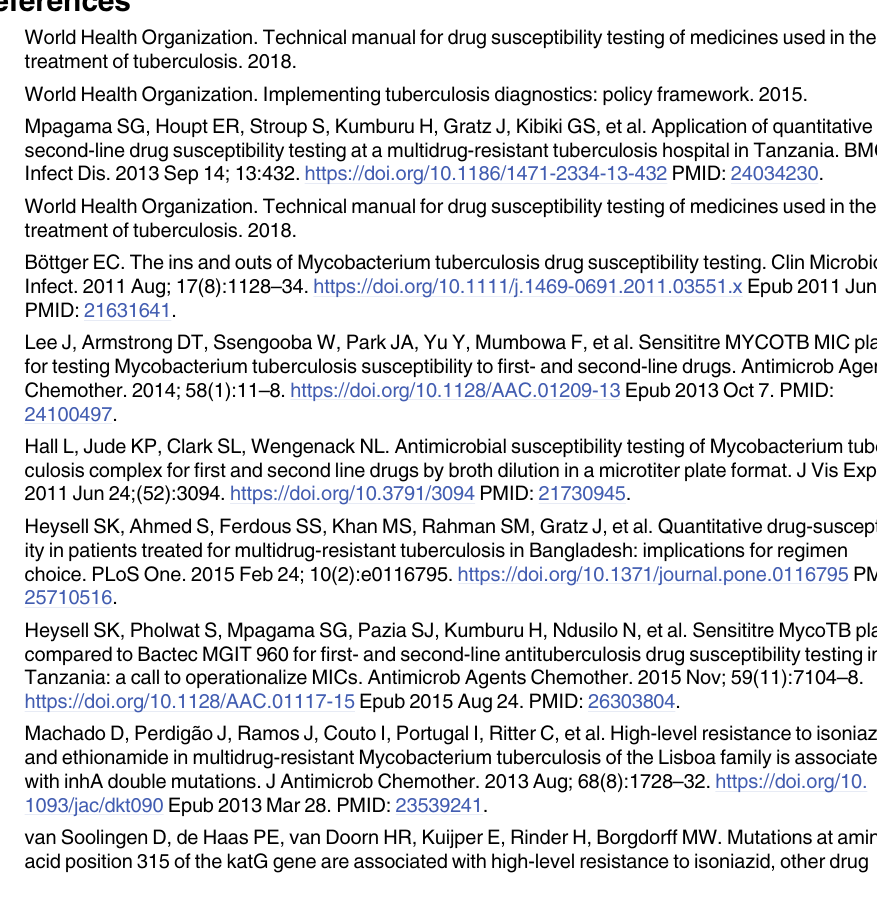
S1 Table. Subculture growth characteristics of multidrug resistant (MDR), rifampin resis- tant (RR) and isoniazid (INH) resistant Mycobacterium tuberculosis isolates in newly diag- nosed and previously treated TB patients. No growth indicates Mtb did not grow; not retrieved indicates the Mtb isolate could not be located and therefore, subculture was not per- formed; insufficient growth indicates that the colony count was between 3 and